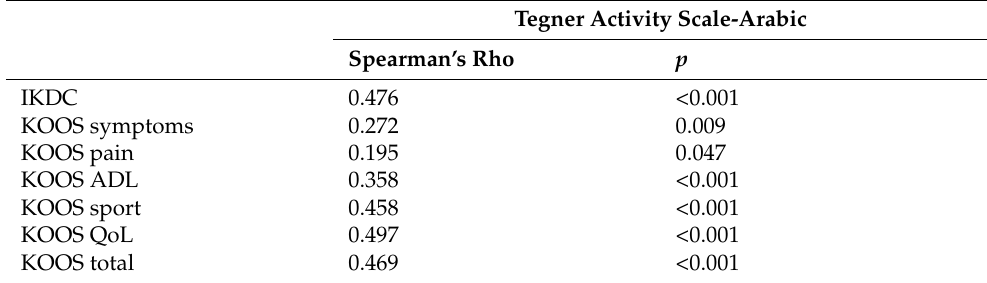
Table 4. Correlations between the Arabic version of the Tegner activity scale and other outcome measures in patients with ACLR ( n =